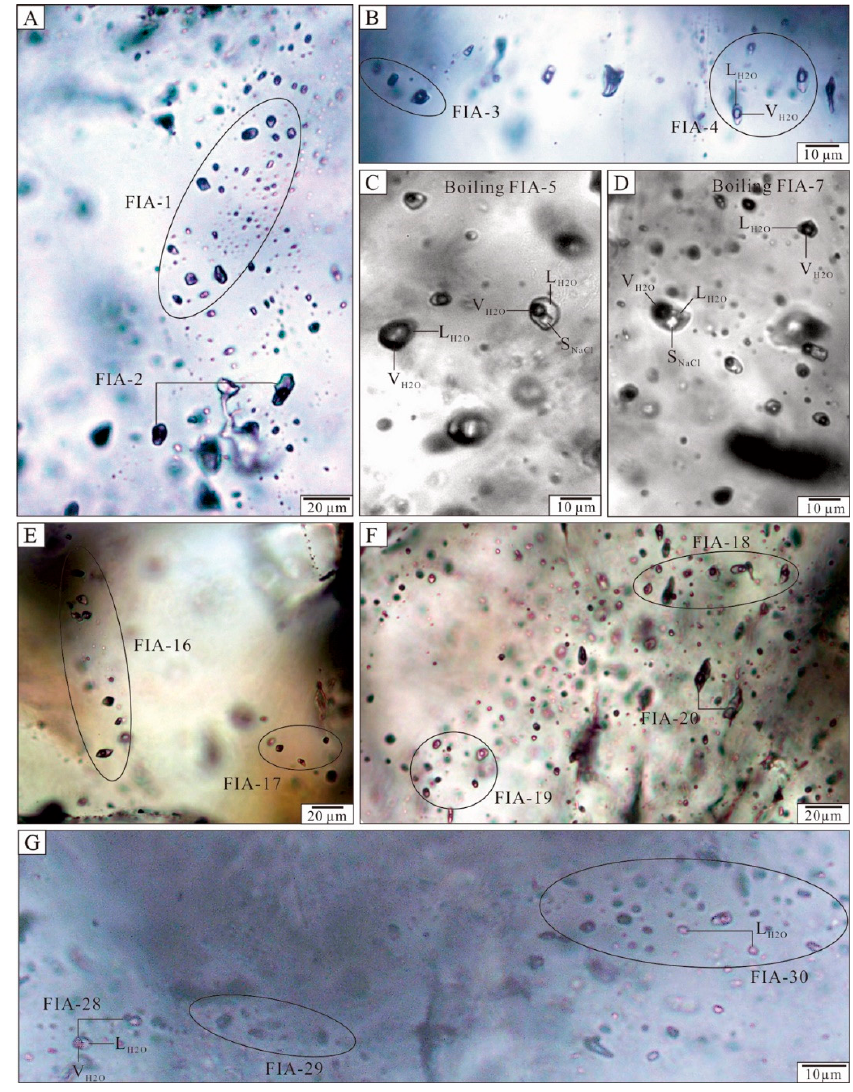
Figure 6. Photomicrographs of FIAs in quartz from stages 1–3 of the Kuergasheng Pb–Zn deposit. ( A )